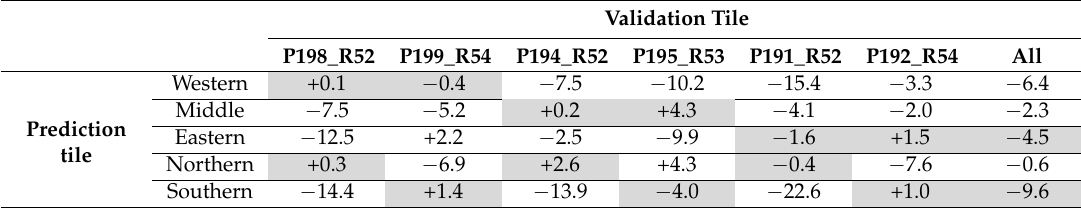
Table 5. Comparison of MAE values from results of two (Northern and Southern) or three (Western, middle, and Eastern) tile predictions with values obtained when all six tiles were used for prediction. Note: Negative values indicate instances where the former returned a higher MAE compared to the latter and positive values indicate the reverse situation. Gray fields highlight differences of MAE when the entire procedure would have been run on the prediction tiles